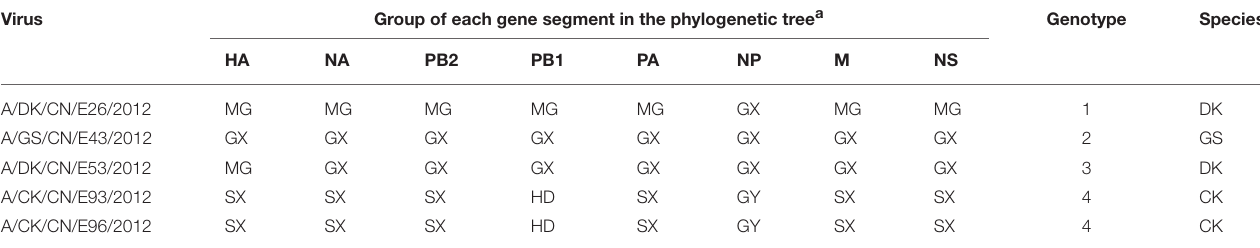
TABLE 1 | Genotypic evolution of the H5N1 viruses isolated in China in 2012. Virus Group of each gene segment in the phylogenetic tree a